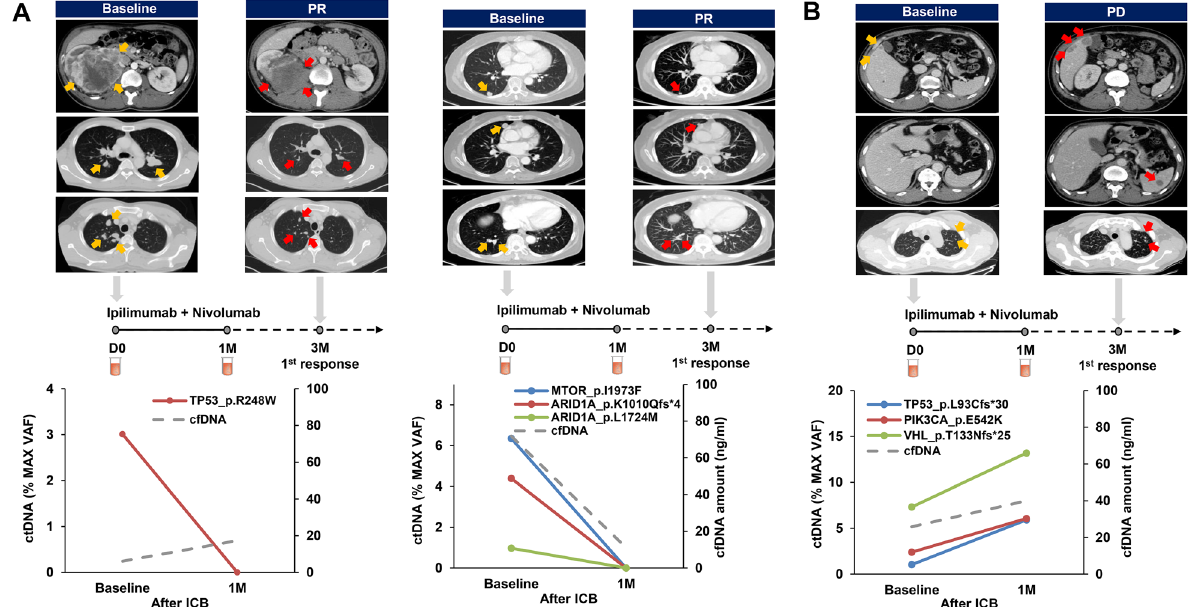
Figure 4. Monitoring therapeutic responses to first-line immune checkpoint blockades (ICB) in patients with metastatic renal cell carcinoma (mRCC). The levels of circulating tumor DNA (ctDNA) were estimated in patients before and after 4–6 weeks of first-line ICB treatment. ICB agents and therapeutic responses are described at the top of the graph for each patient. The therapeutic responsiveness was determined after 3 months of treatment based on abdomen-pelvis and chest CT scans. ( a ) Two patients were classified as showing partial response (PR). ( b ) One patient was classified as showing progressive disease (PD) according to the iRECIST